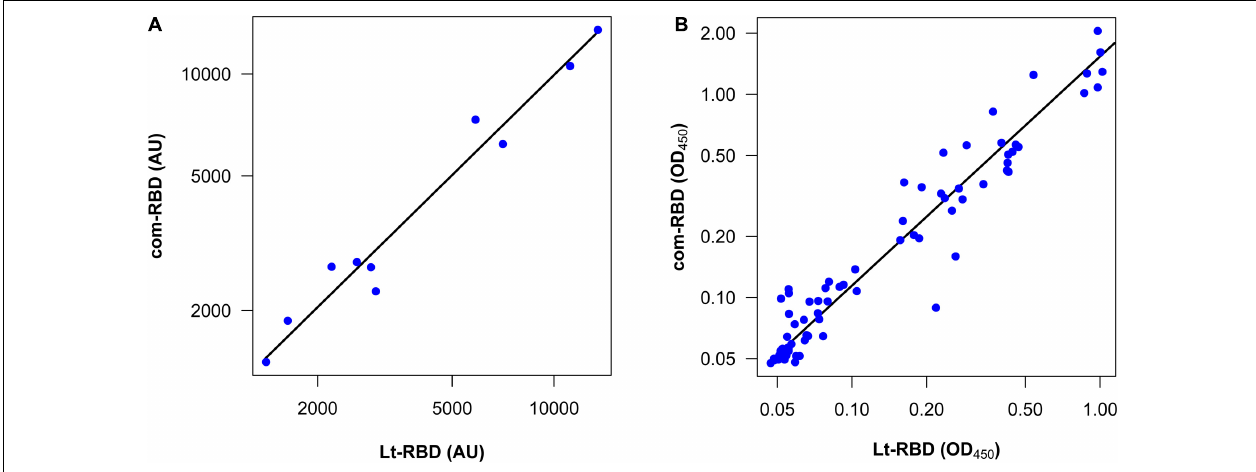
FIGURE 4 | Correlation between the com-RBD and Lt-RBD antibody responses of human sera. (A) Antibody titers of 10 COVID-19–positive samples ( n = 10); (B) OD 450 values of COVID-19–positive and COVID-19–negative human sera ( n =